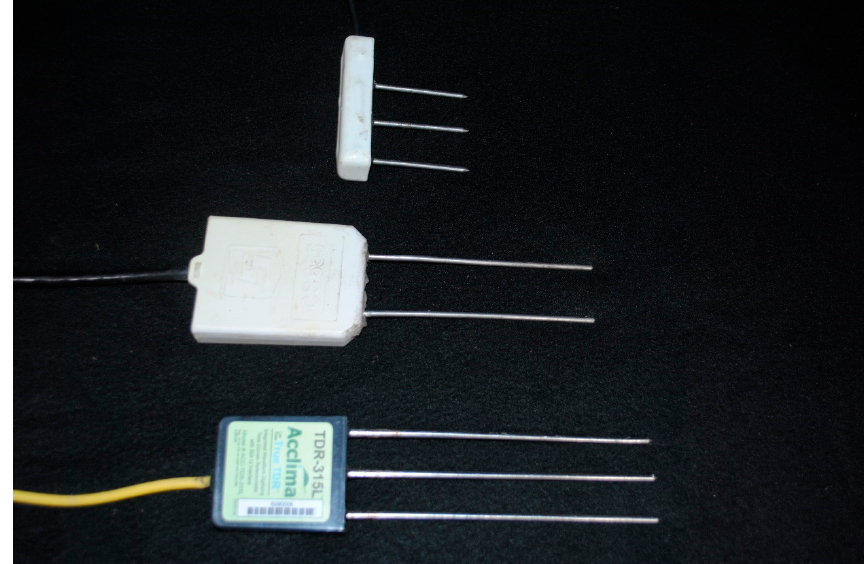
Figure 1. Electromagnetic soil moisture sensors used in fruit tree trunks. From top to bottom: Decagon Devices GS3, Campbell Scientific CS655, Acclima TDR-315(L). TDR-315 and 315L are nearly identical in specification and were treated as the same sensor for the study. Only the TDR-315L is pictured